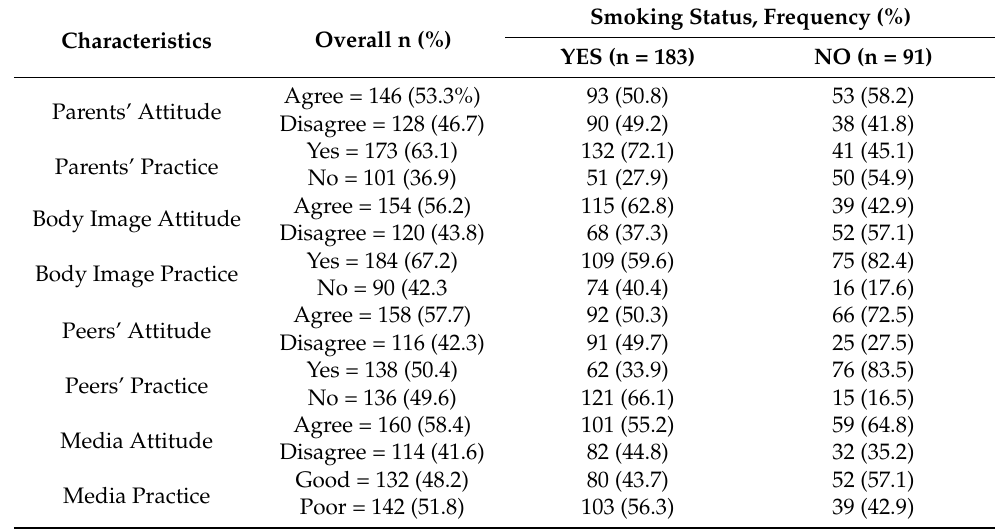
Table 2. Summary of factors influencing smoking among women inmates in